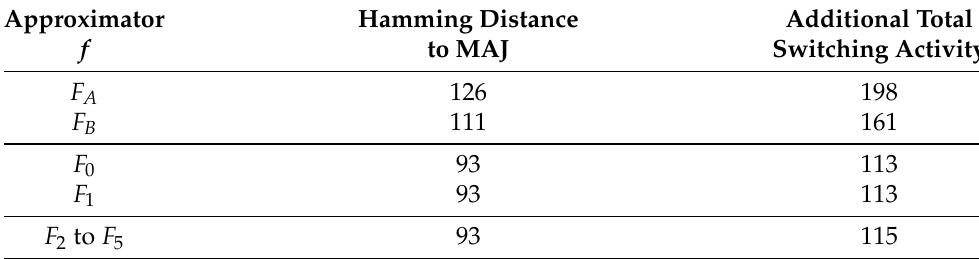
Table 2. Hamming distances and additional switching activities to the majority